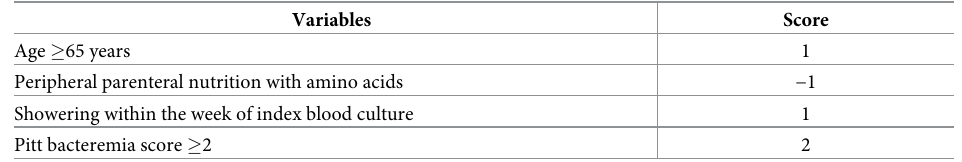
(Table 3). Meanwhile, use of peripheral parenteral nutrition with amino acids was identified as an independent predictor (OR, 0.31; 95% CI, 0.10–0.98) for PVC-associated non-gram-nega- tive bloodstream infections. Based on these results, we estimated the probability of gram-negative bloodstream infec- tions as 1/(1+e -y ) (y = 0.284934 + 1.122872 × “age � 65 years” − 1.166058 × “use of peripheral